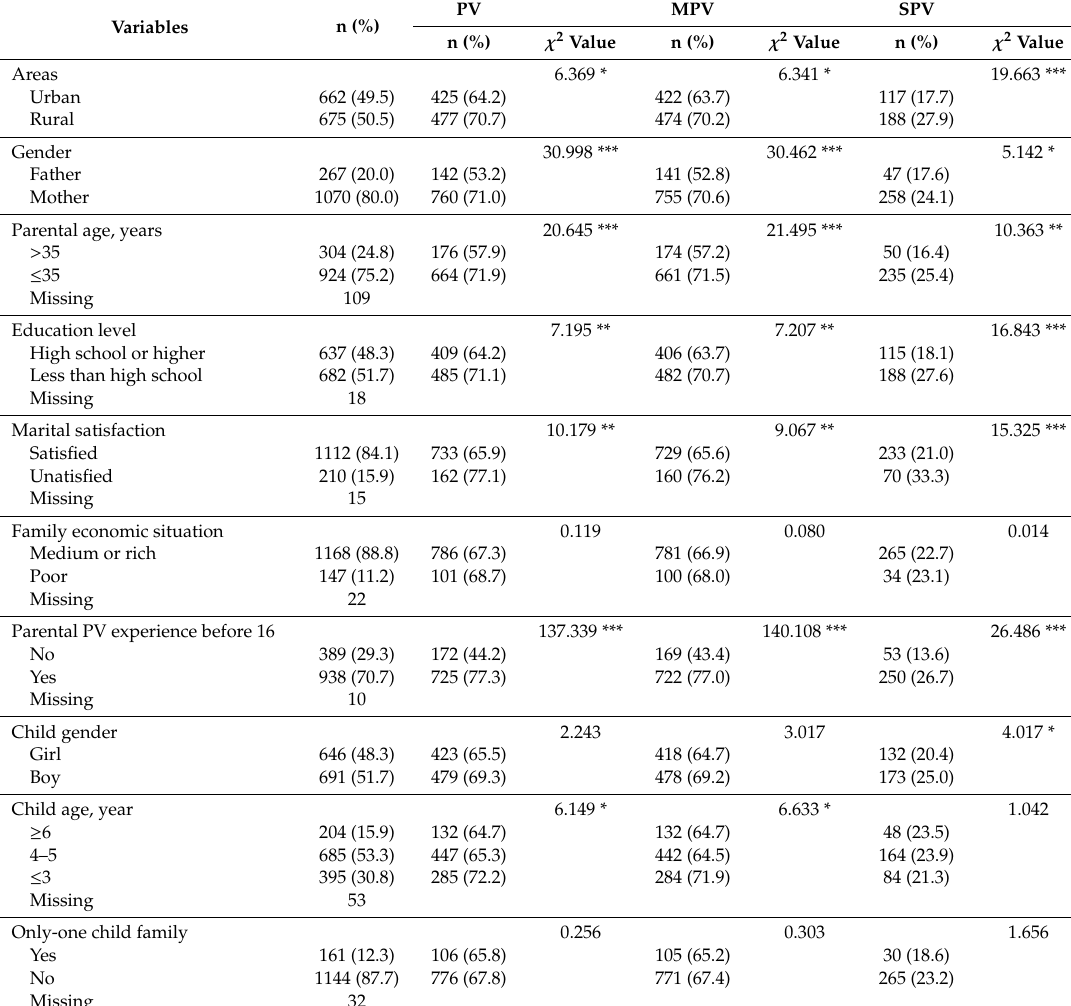
Table 1. Respondents’ characteristics and bivariable associations with parental PV behavior to children.